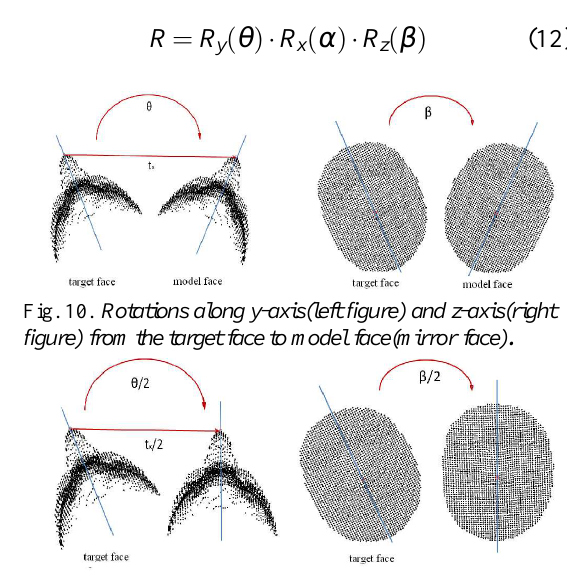
Fig. 11. The target face is aligned to a perfect front view position according to the q and b generated by applying ICP to rotate target face to model face (mirror